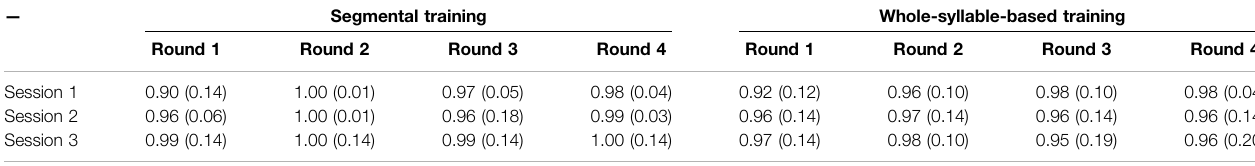
TABLE 5 | The accuracy rates in the exercises across training sessions in both segmental and whole-syllable-based training groups.